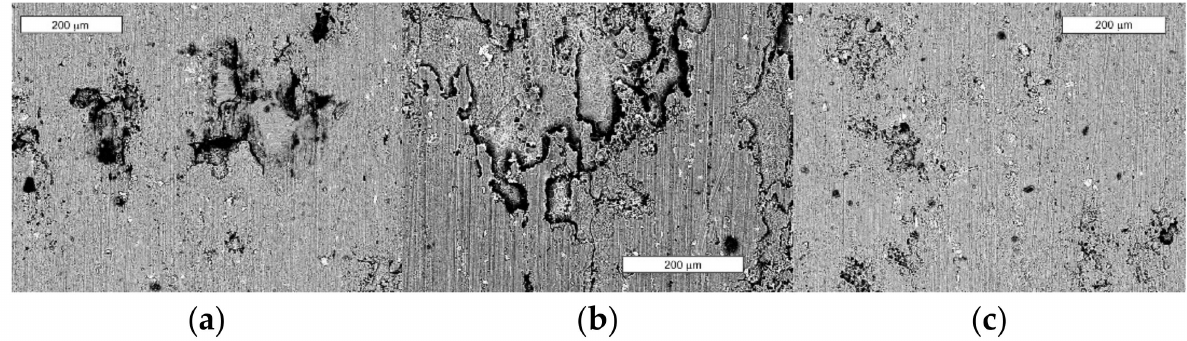
Figure 13. SEM images obtained from the surface of samples after the NSS test at low magnifica- tion:state T6 ( a ), DA ( b ), RRA ( c ), and